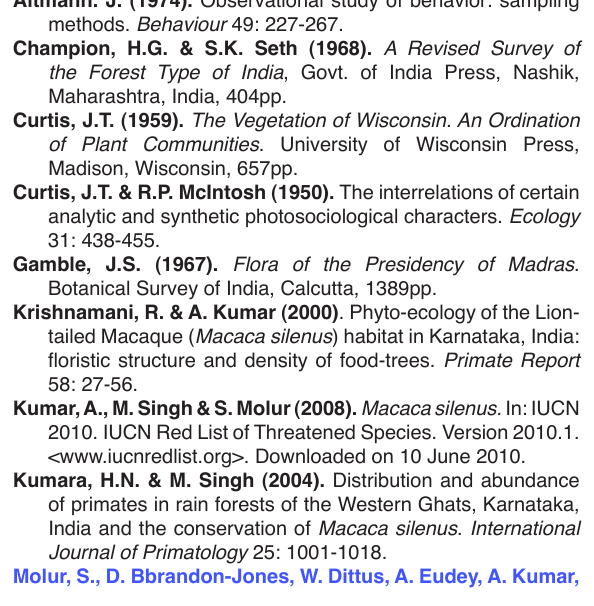
area marks the northern end of the distribution of low and medium elevation dipterocarp forests (Pascal 1998). This region is also the northern end of the distribution of the threatened Lion-tailed Macaques (Kumara & Singh